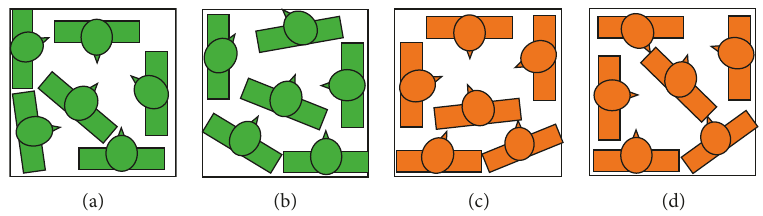
Figure 7: 6 p/m 2 , green: remaining silent, orange: speaking, door at the top.